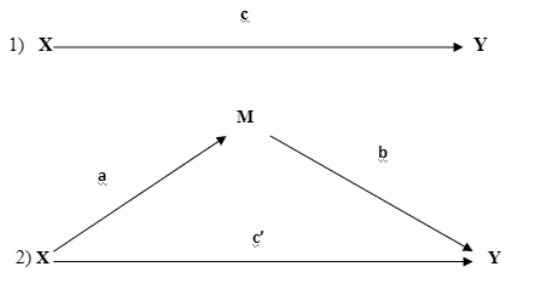
Fig. 2. Graphic expression of 1) the direct effect of X on Y and 2) the indirect effect of X on Y when a mediator is introduced Source: Preacher, & Hayes,